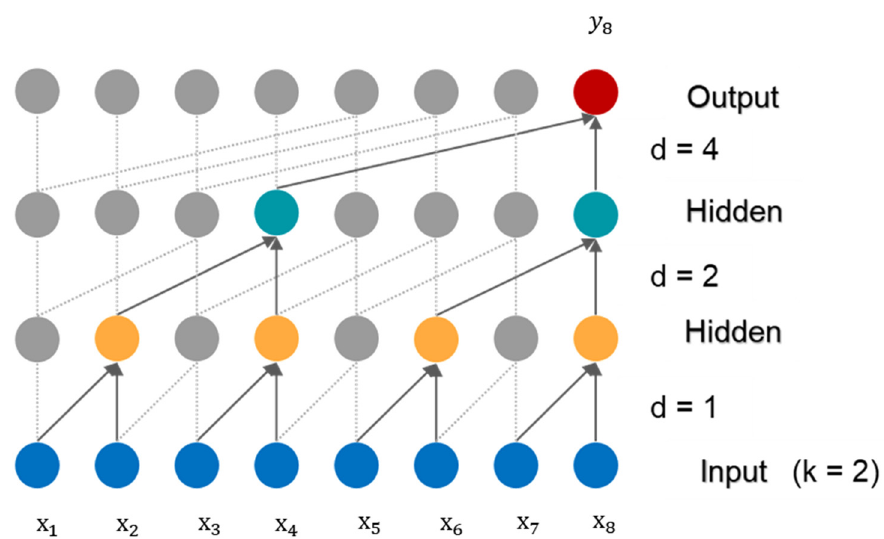
Figure 1. Causal dilation convolution structure.